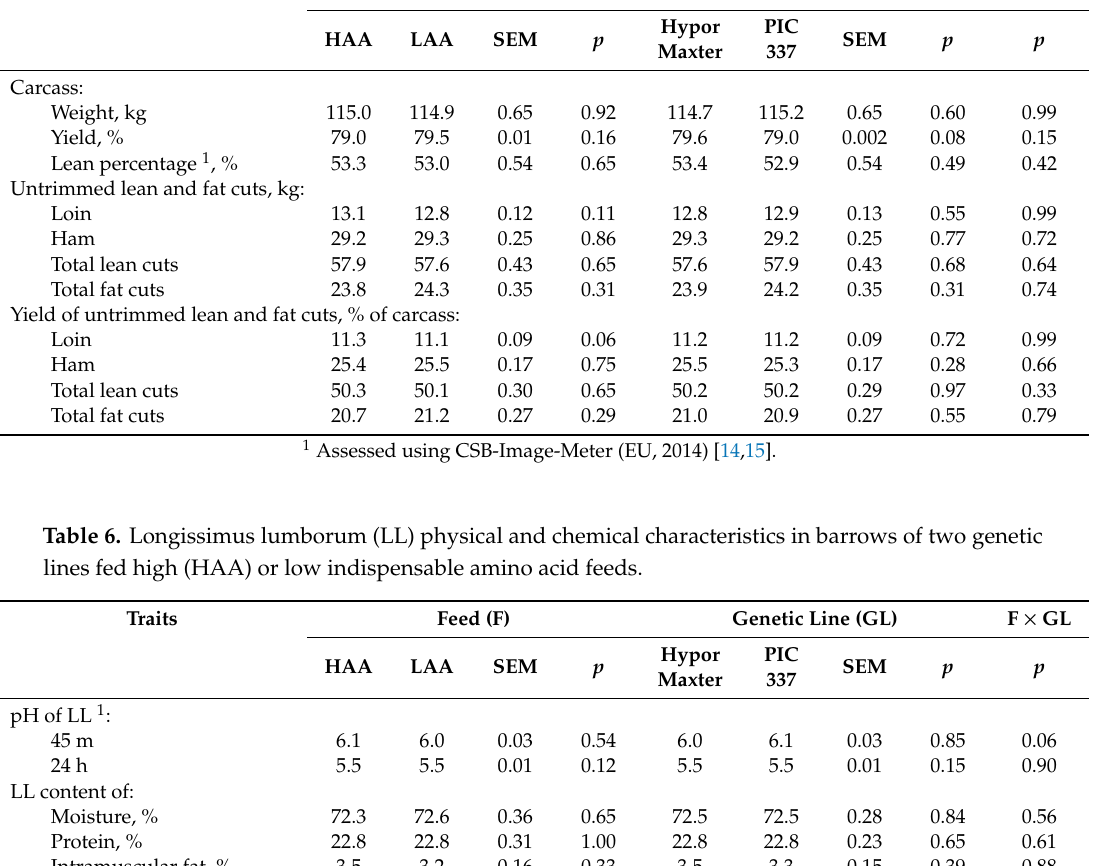
Table 5. Carcass traits of barrows of two genetic lines fed high (HP) or low (LP) indispensable amino acids feeds. Traits Feed (F) Genetic Line (GL) F × GL